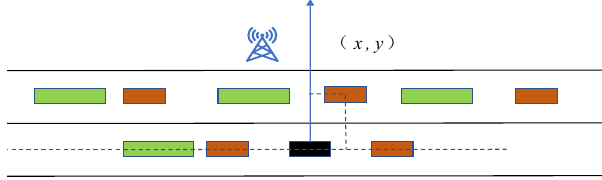
Figure 2. Vehicle shape-coding diagram.